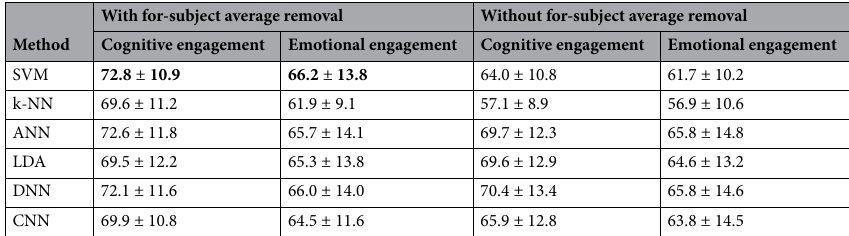
Table 4. Cross-subject experimental results using FBCSP followed by TCA. Accuracies are reported with and without for-subject average removal for cognitive engagement and emotional engagement detection. The best performance values are highlighted in bold.